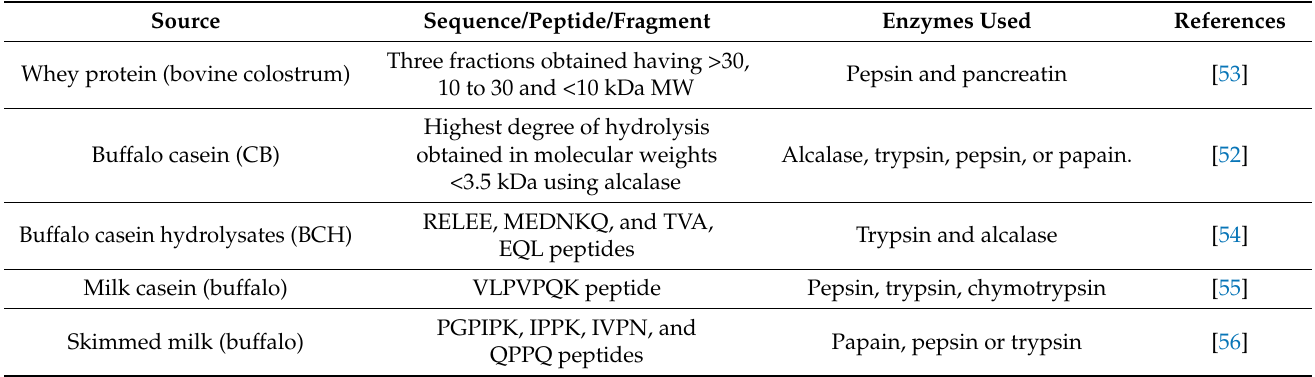
Table 4. Milk-derived peptides produced using enzymatic hydrolysis